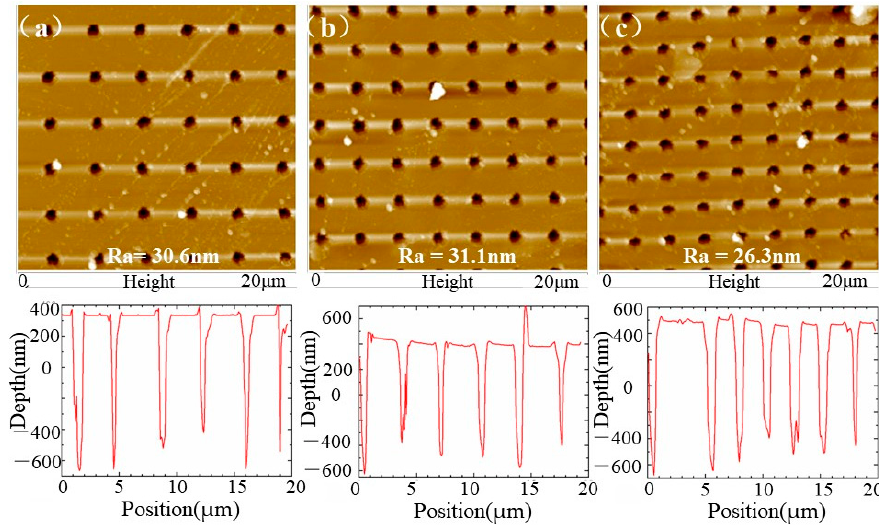
Figure 3. AFM images of micropore arrays with different periods. ( a ) 3.6 μ m period; ( b ) 3.0 μ m period; ( c ) 2.6 μ m period.